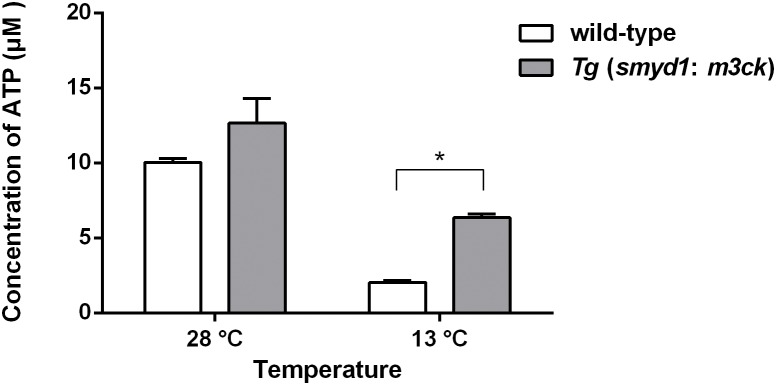
ATP concentration in transgenic and non-transgenic fish at 28°C or 13°C.The concentration of ATP in Tg (smyd1:m3ck) and wild-type fish was measured at the indicated times. Data were analyzed by one-way ANOVA and t-test. Data represent mean ± S.E.M. (n = 5). “*”indicates P<0.05.